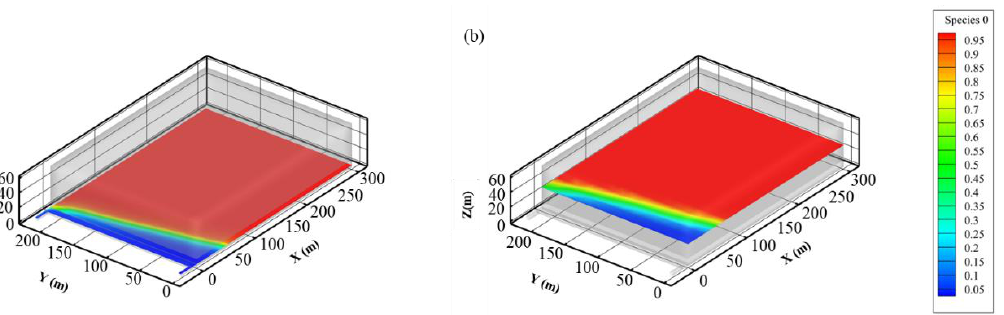
Figure 10. Gas migration and reservoir characteristics simulated by the distribution characteristics of porosity in the control group ( a ) caving zones and ( b ) fracture zones.